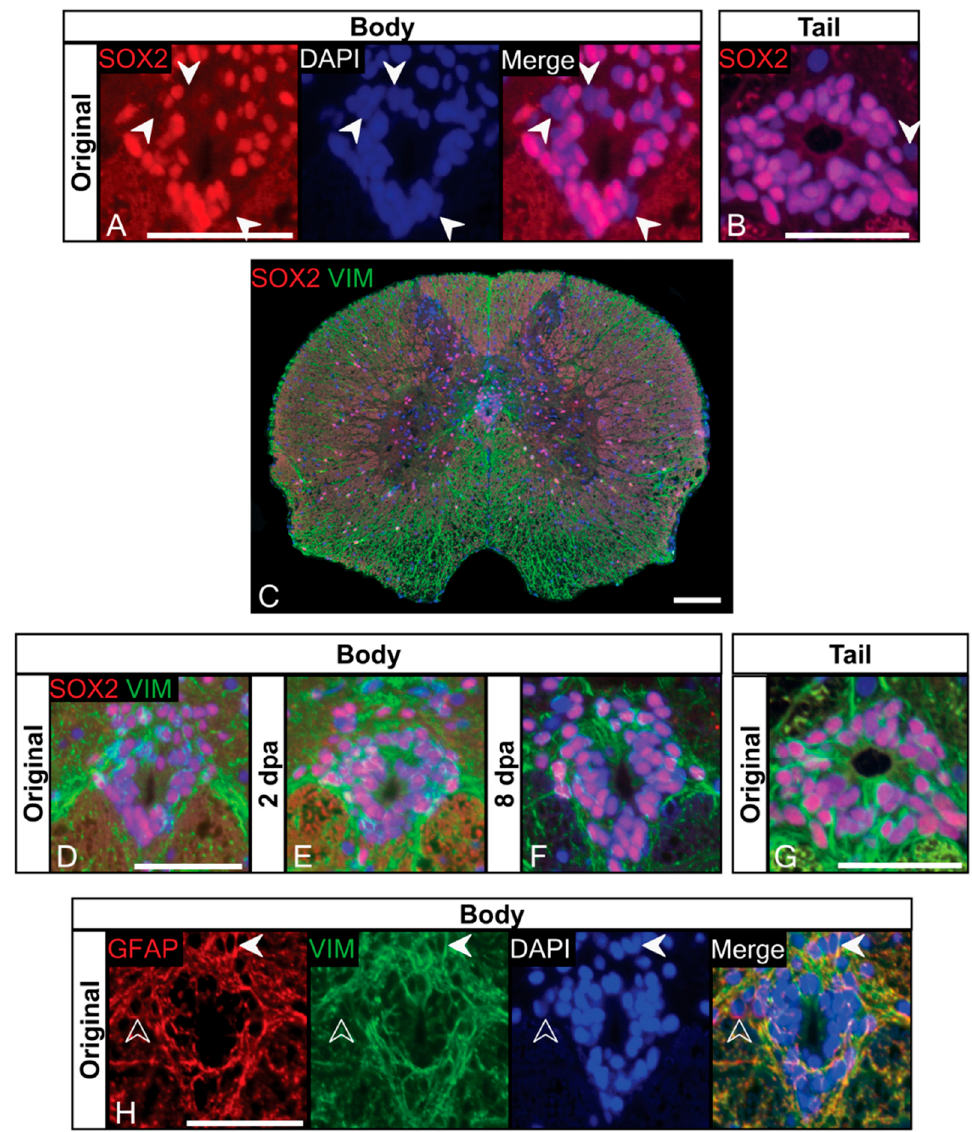
Figure 4. Ependymal cells of the trunk spinal cord express NSPC markers SOX2, Vimentin and GFAP. ( A , B ) The majority of ependymal cells in the trunk and tail spinal cord express NSPC marker SOX2. SOX2– ependymal cells are marked with white arrows. ( C ) SOX2/Vimentin expression in the trunk spinal cord. Vimentin expression is largely confined to the ependymal layer and white matter. A fascicle of Vimentin+ fibers is seen projecting toward the pia within the dorsal medial septum. ( D - F ) SOX2/Vimentin expression in the ependymal layer of the trunk spinal cord before ( D ), 2 days ( E ) and 8 days ( F ) post-autotomy. Note that expression remains unchanged across time points. ( G ) SOX2/Vimentin is expressed by ependymal cells of the original tail spinal cord, and mirrors expression in the trunk spinal cord. ( H ) A representative section from the cranial segment of the trunk spinal cord. The majority of Vimentin+ ependymal cells co-express radial glia marker GFAP (filled arrows). GFAP+/Vimentin– ependymal cells are also present within the ependymal, slightly offset from the central canal (open arrows). dpa = days post-autotomy. Scale bars: ( A , B , D – F , G , H ) = 10µm; ( C ) = 20 µm.